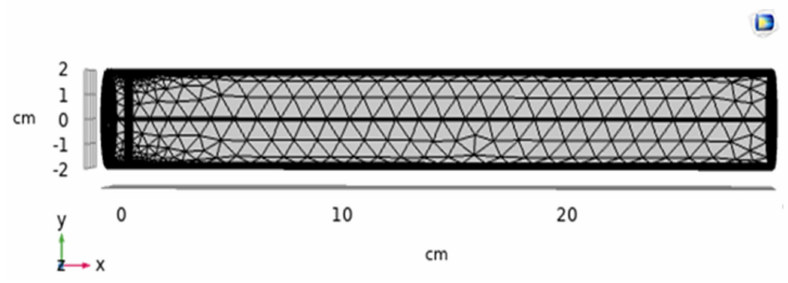
Figure 3. Antenna and sandstone core geometry mesh.